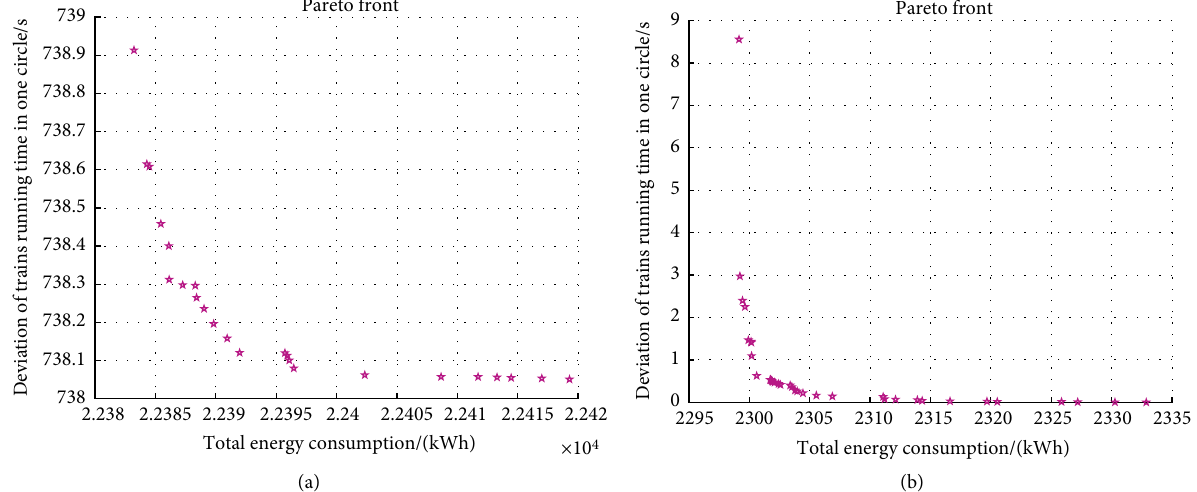
Figure 17: The Pareto front under and OIC = 0.4. (a) The Pareto solutions of the OEST. (b) The Pareto solutions of the OQOST. 𝐺 = 150